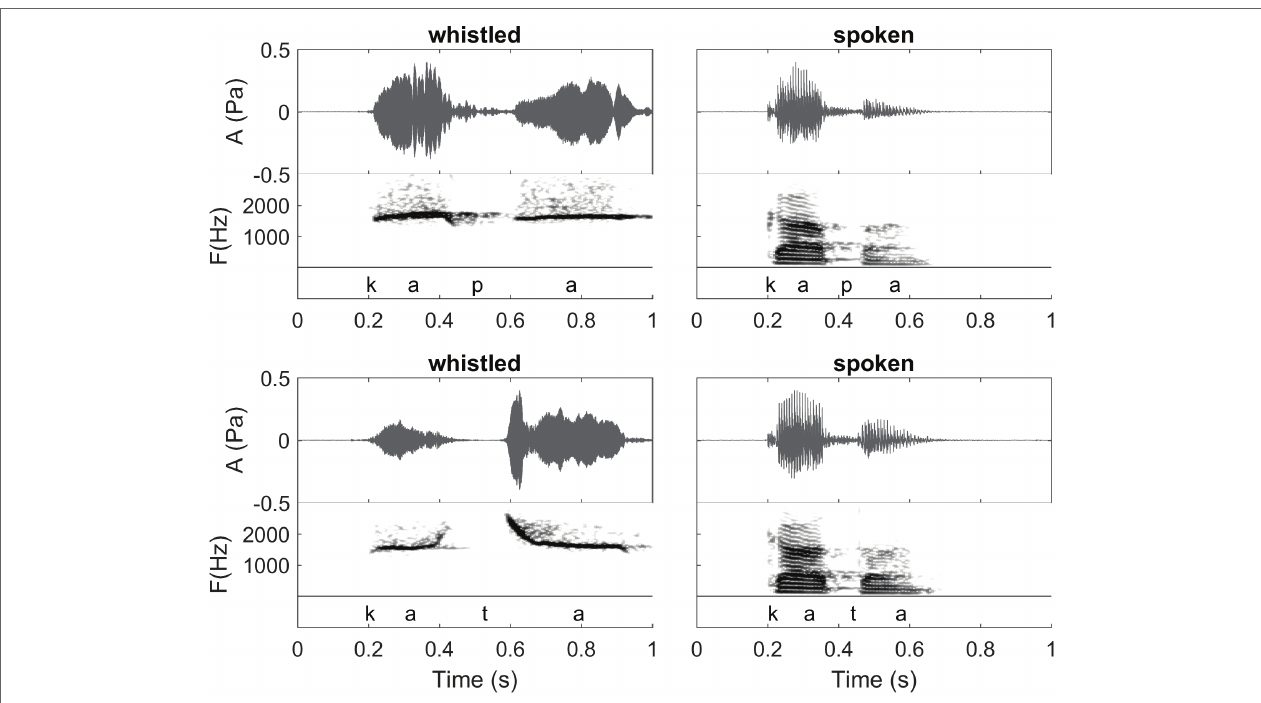
FIGURE 1 | Waveforms and spectrograms of the words /kapa/ (Spanish orthography: “capa”; meaning: “hat” in English) and /kata/ (Spanish orthography: “cata”; meaning “tasting” in English) in spoken (right) and whistled (left) forms. All utterances are from the same speaker. Note the clear spectral difference between the two modalities (whistled vs. spoken). The common spectral dynamics between spoken speech and whistled speech can be observed clearly in the first /a/ because it was pronounced with more power than the second one in the spoken speech modality. The coarticulation of the initial /k/ with /a/ shows that for /ka/ whistled frequencies are close in shape to the dynamics of the first formant of spoken speech, whereas for the coarticulation /at/ whistled frequencies are close in shape to the dynamics of the second formant of spoken speech (see also “General description of dolphin and human whistled communication systems” on this topic; Recordings and edition by Julien Meyer, listen to sound extracts in Meyer and Diaz,